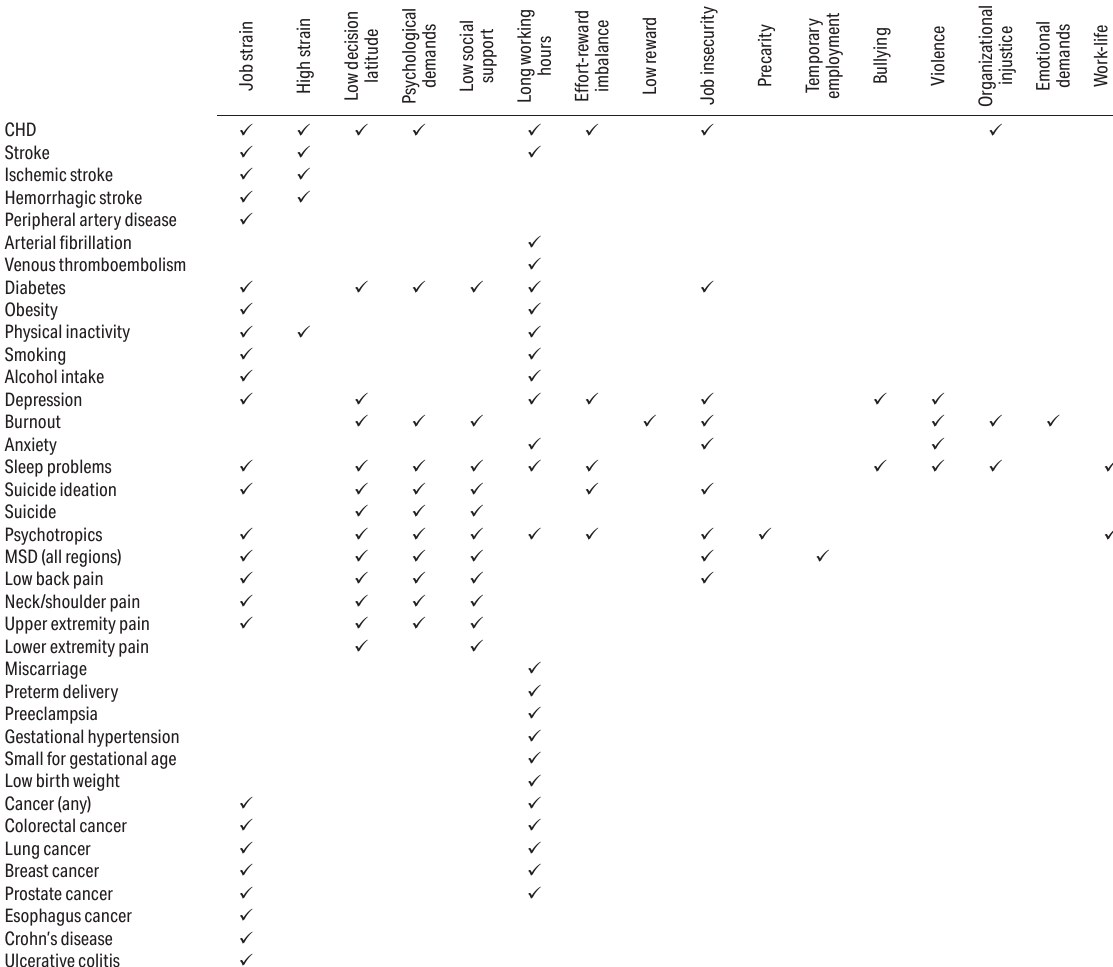
Table 1. Summary table of all exposure-outcome associations studied in at least one of the included reviews.  =at least one available pooled